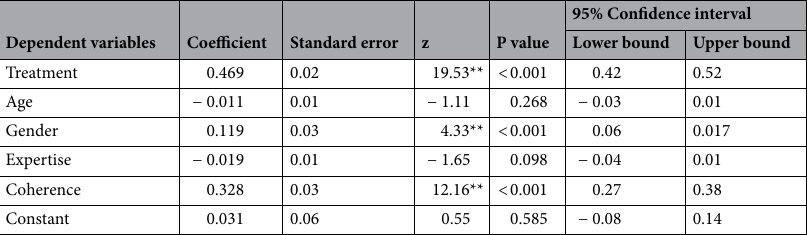
Table 4. Random intercept model. *Statistically significant with p < 0.05; **statistically significant with p < 0.01; Model fitting: Wald χ 2 = 560.3, p <